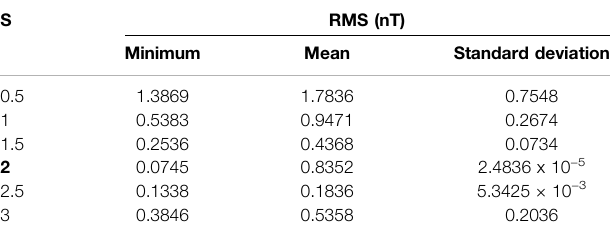
TABLE 3 | Statistical results for RMS values obtained from parameter tuning of MRFO for synthetic magnetic